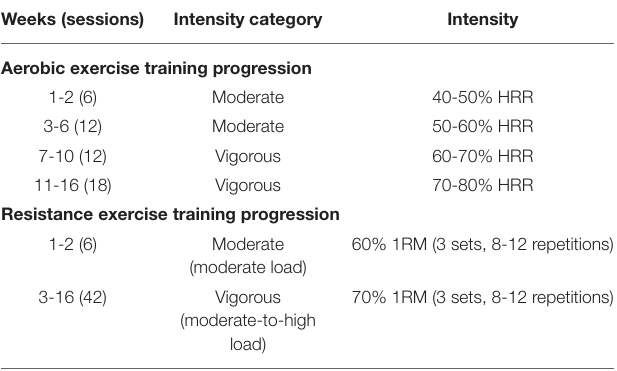
TABLE 3 | Exercise training progression for the traditional